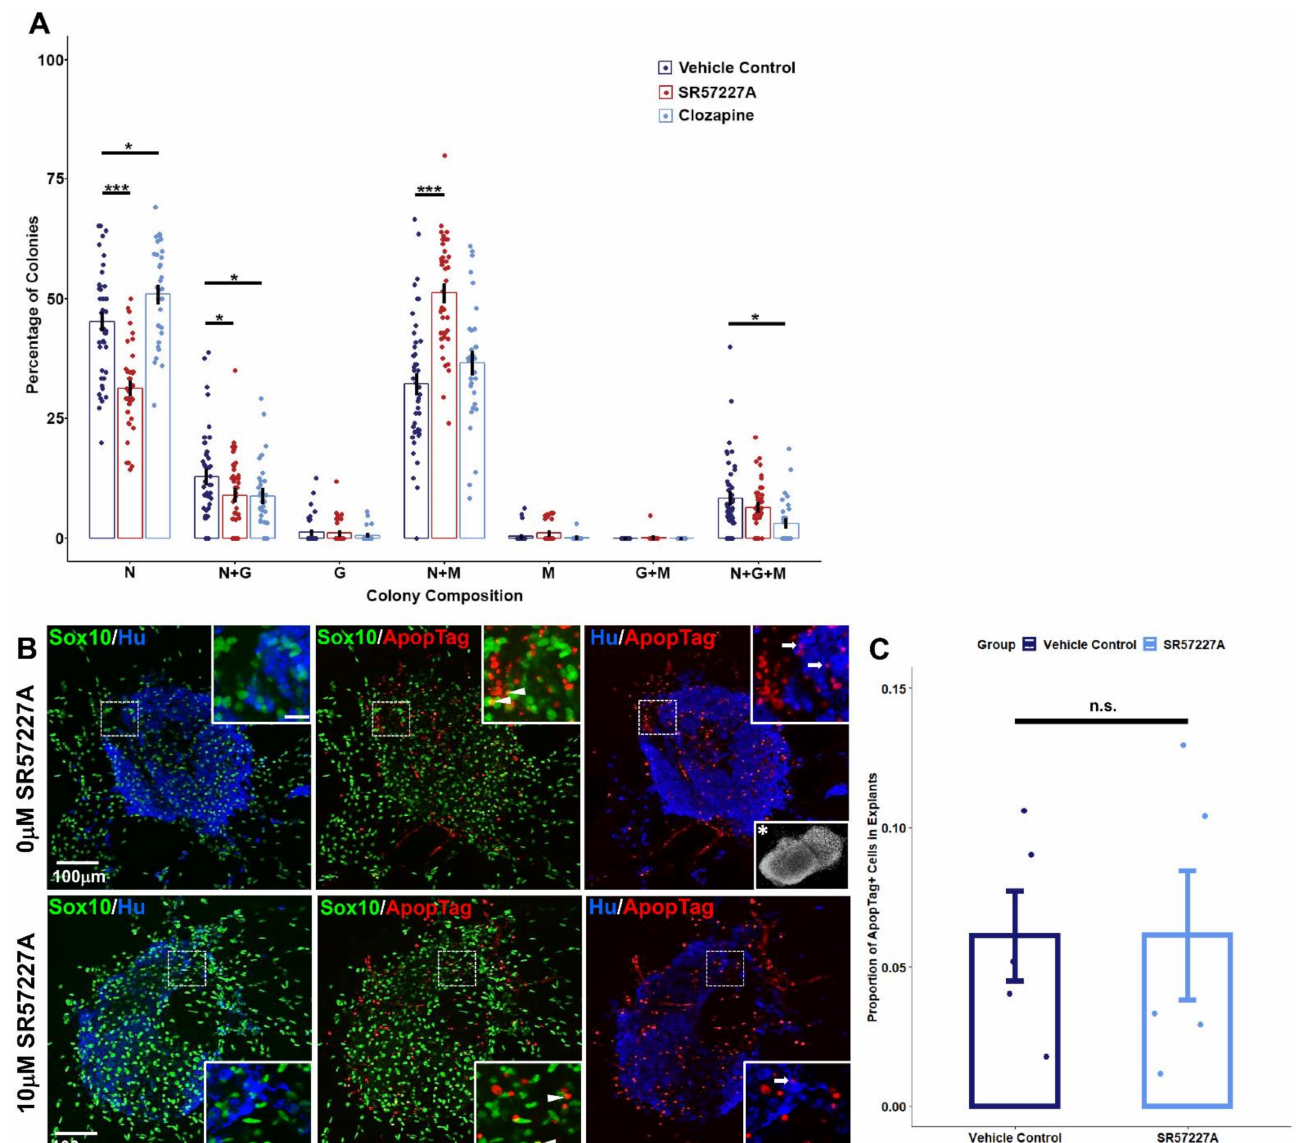
Figure 4. Pharmacologically perturbing serotonin signaling alters the differentiation outcomes of sacral NCPs in vitro. ( A ) Sox10 -H2BVenus+ sacral NCPs were flow-sorted from 13.5 dpc pelvic ganglia and then grown in low-density cultures and treated with drug vehicle (negative control), SR57227A (specific 5-HT3 receptor agonist), or clozapine (mixed antagonist of several serotonin receptors). Mean ± SEM percentage of colonies expressing markers of differentiated cell types including neurons (Peripherin+, N), glia (GFAP+, G), and myofibroblast (Smooth Muscle Actin+, M) after exposure to either vehicle control, SR57227A, or clozapine are plotted. * p < 0.05, *** p < 0.001, assessed by Welch’s t -test. n = 33 − 45 wells per treatment condition. ( B ) Confocal images of 13.5 dpc Sox10 -H2B-Venus (green) pelvic ganglia explants cultured in the presence or absence of the 5-HT agonist SR57227A and subjected to detection of apoptotic cells (red, ApopTag) followed by immunohistochemistry with Hu C/D antibody, a pan-neuronal marker. Occasional apoptotic glial cells (arrowheads) and neuronal cells (arrows) are indicated. The scale bar for all insets is 20 µ m. Representative DAPI staining reveals the explants also contain a non-glial, non-neuronal cell population and that the majority of apoptotic events take place in this population (inset with asterisk, 120 × magnification). ( C ) Quantification of proportions of ApopTag+ cells out of total cells in pelvic ganglia explants. p = 0.99, Welch’s t